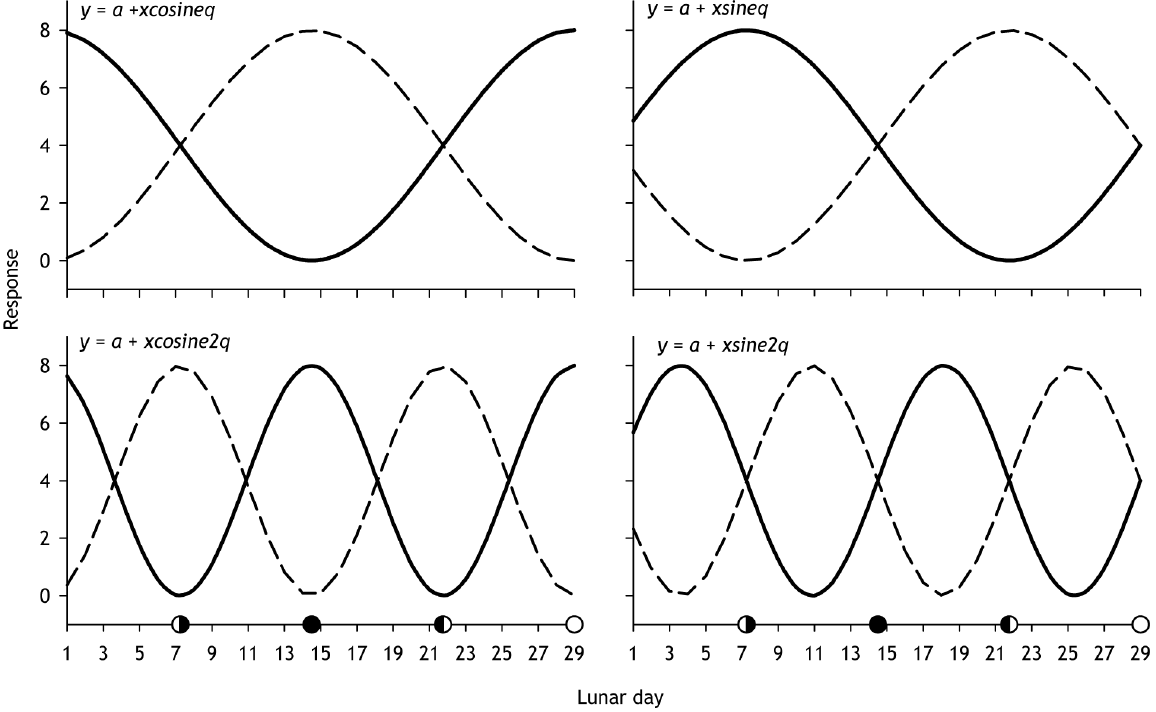
Figure 2. Simulated patterns for single lunar predictor periodic regression models. For each simulation, a was set at 4. For models with solid lines x was set at 4. For models with dashed lines x set at -4. The lunar cycle starts at 0001 h on the morning after the full moon. Response corresponds to catch, CPUE, or angler effort. In these simulations, the maximum relative effect is 100%.